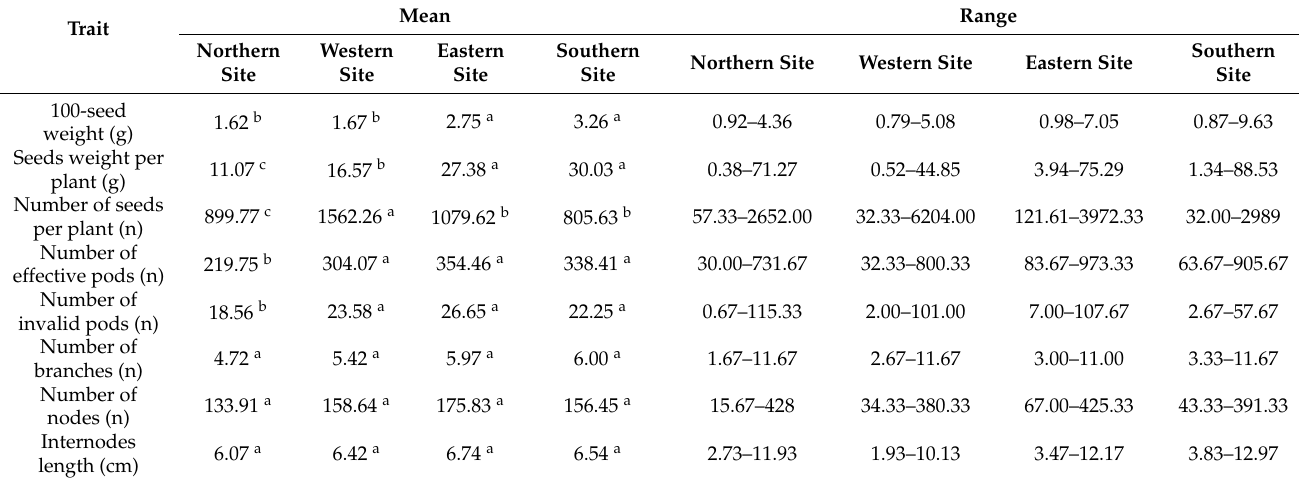
Table 5. Mean and range of the agronomic traits in four collecting sites, based on the means in the years of 2012 and 2013.